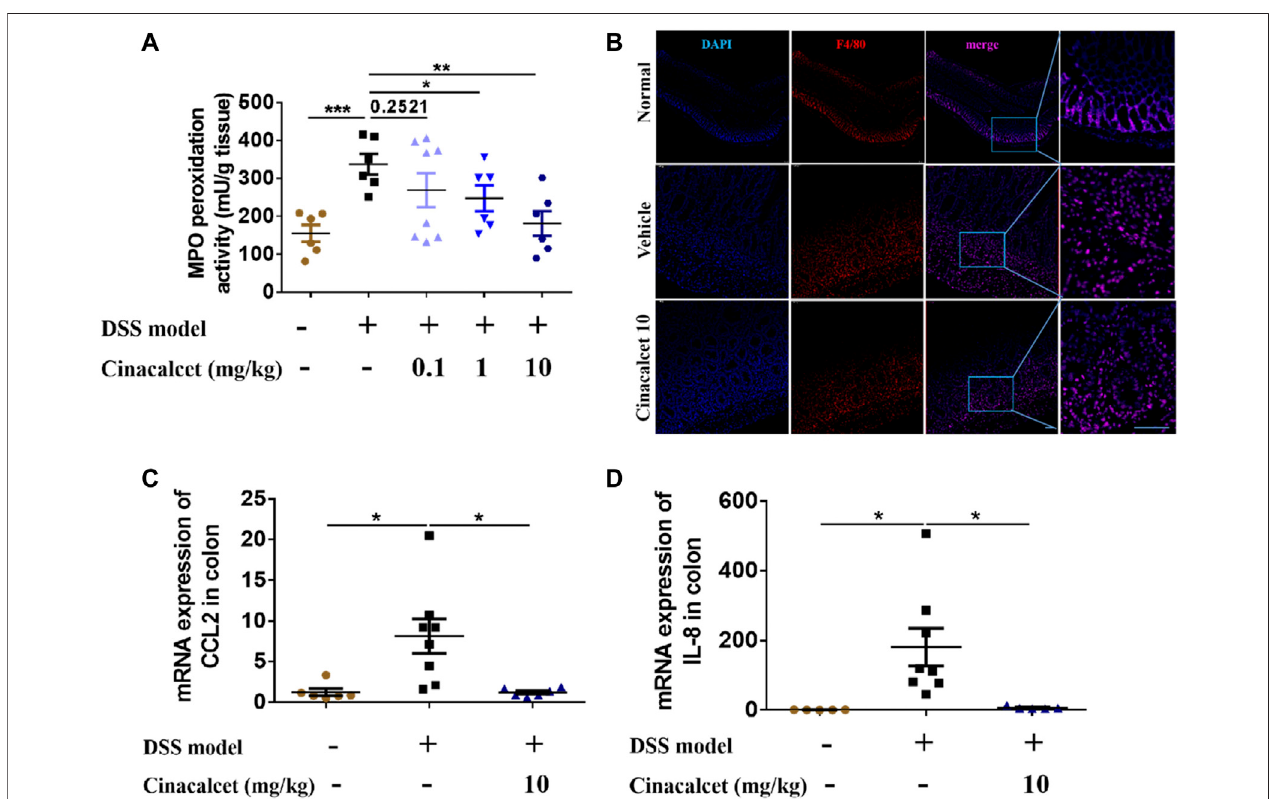
FIGURE 4 | Cinacalcet redcues in fl ammatory cell in fi ltration in dextran sulfate sodium (DSS)-induced colitis model. (A) Myeloperoxidase (MPO) activity was assessed to quantify the in fi ltration of neutrophils in the colon. (B) immuno fl uorescence was conducted to show the in fi ltration of macrophages in the colon (50 μ m). (C, D) qRT-PCRwasperformedtodetectthemRNAexpressionlevelsofchemokines CCL2 and IL-8 inthecolon.* p < 0.05,** p < 0.01,*** p < 0.001.Dataareshownasthe mean with standard